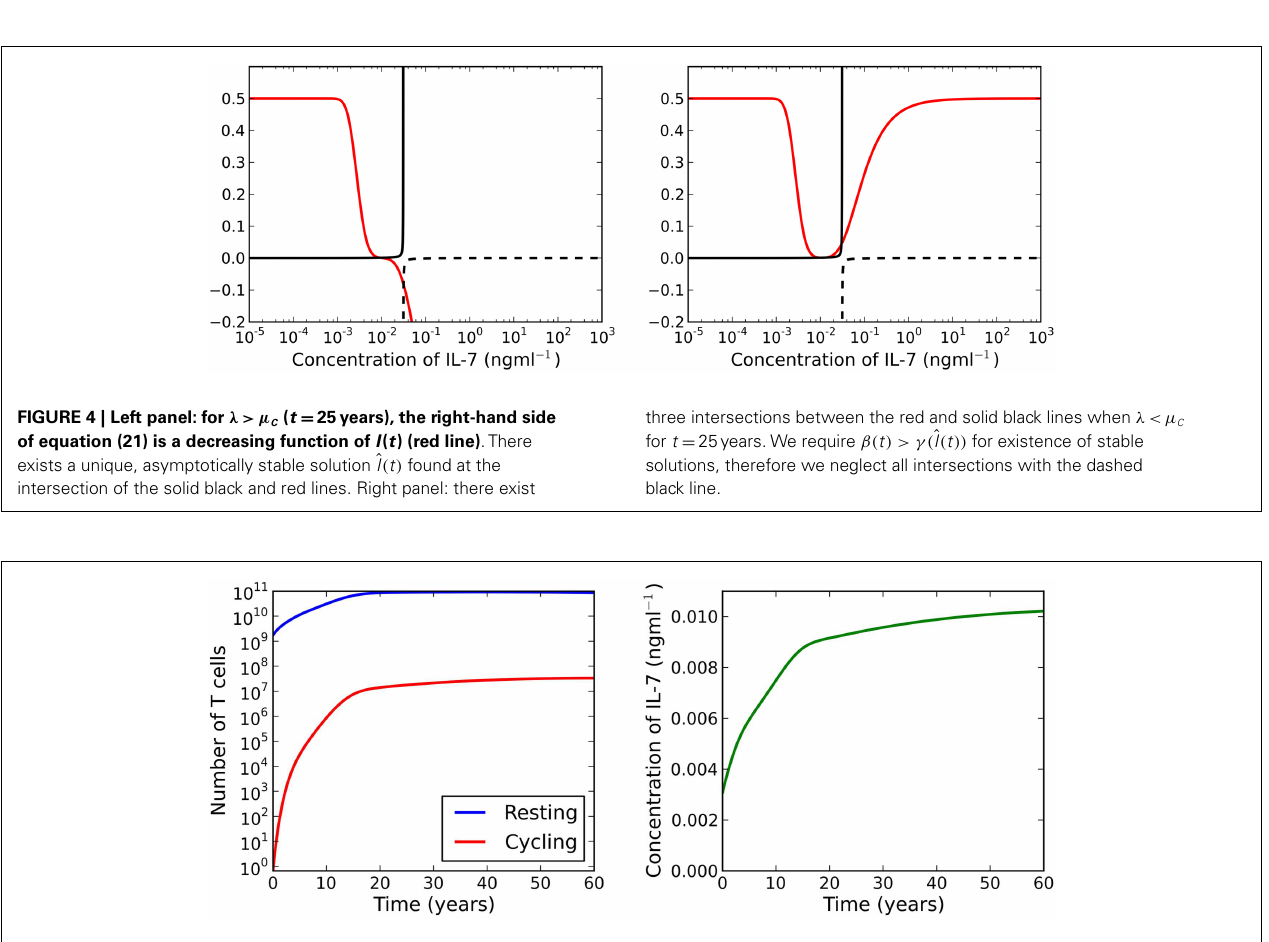
adulthood. During this period we see a 10 7 -fold increase in the number of cycling cells, resulting from increased IL-7 availability and reduced thymic output. IL-7 availability increases continually as the individual ages.